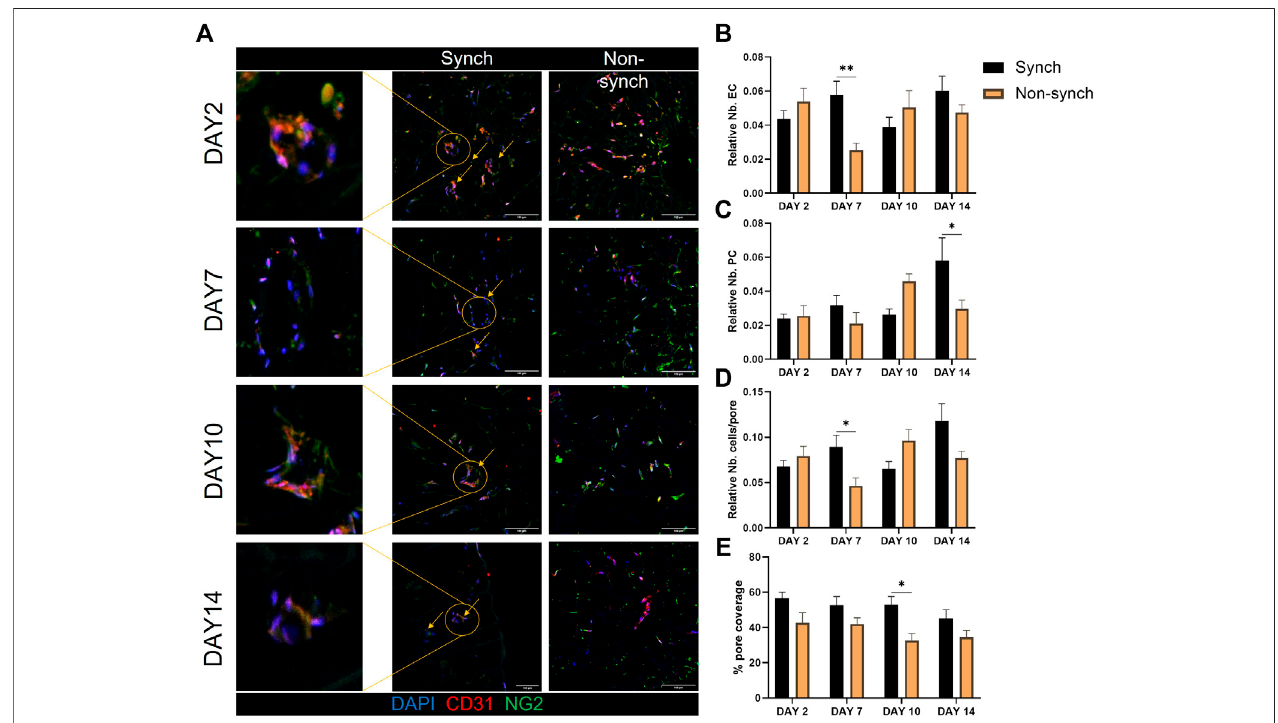
FIGURE 6 | Clock synchronization improves vascular structure formation in 3D. Representative immuno fl uorescence images of synchronized (Synch) and non- synchronized (Non-synch) co-cultures on poly-urethane scaffolds, at different time-points [ (A) , N = 3 for each time point]. Endothelial cells (CD31, red) and pericytes (NG2, green), nuclei in blue (DAPI). Scale bars: 100 µm Quanti fi cation of the number of endothelial cells (B) and pericytes (C) relative to the total number of cells in each pore, total number of cells per pore (D) and percentage of pore coverage (E) was compared in Synch and Non-synch conditions. Two-way ANOVA, * = p < 0.05, ** = p < 0.01 vs. Non-synch at each